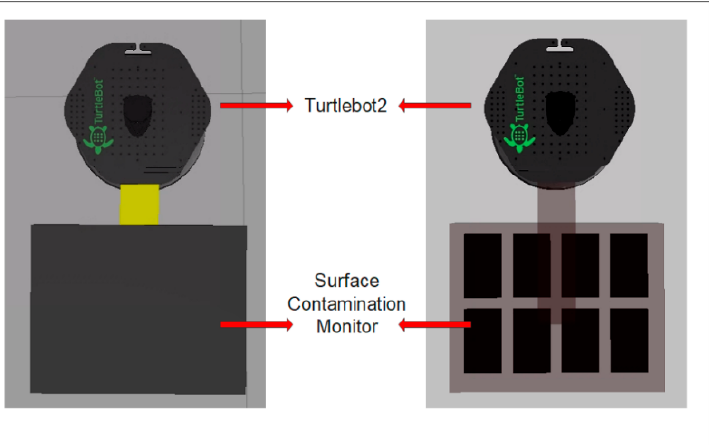
Figure 6. Modeling results for the robotics platform, with model construction results in Gazebo on the left and model visualization results in RVIZ on the right.